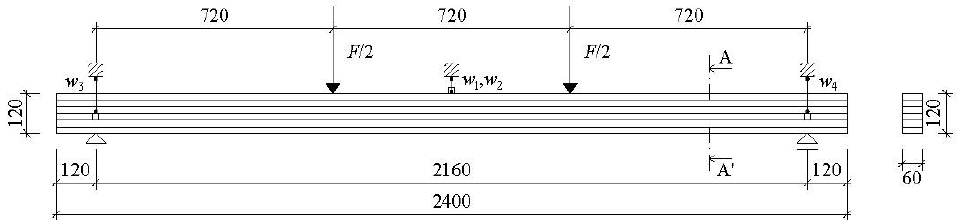
Figure 3. Geometry of the GLT beam test in the four-point bending test. Dimensions in mm.